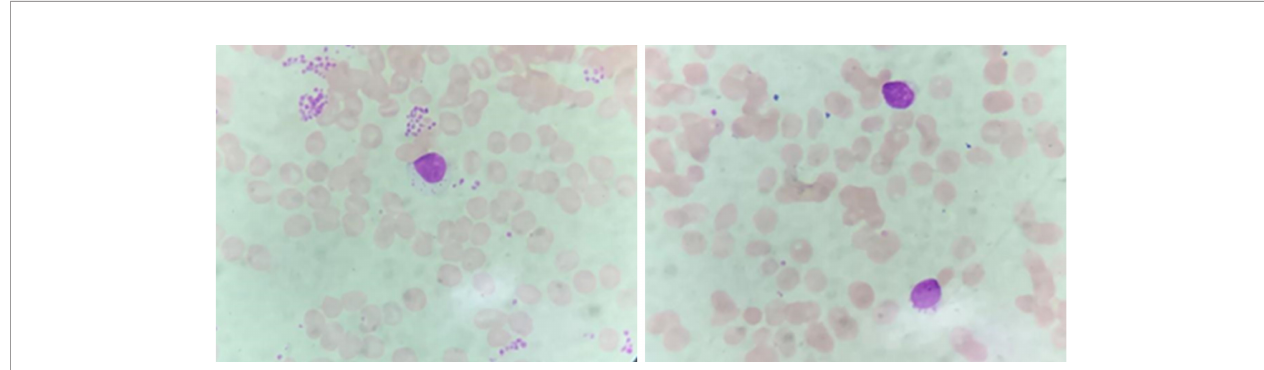
FIGURE 4 | Large granular lymphocytes in bone marrow cytology smear.